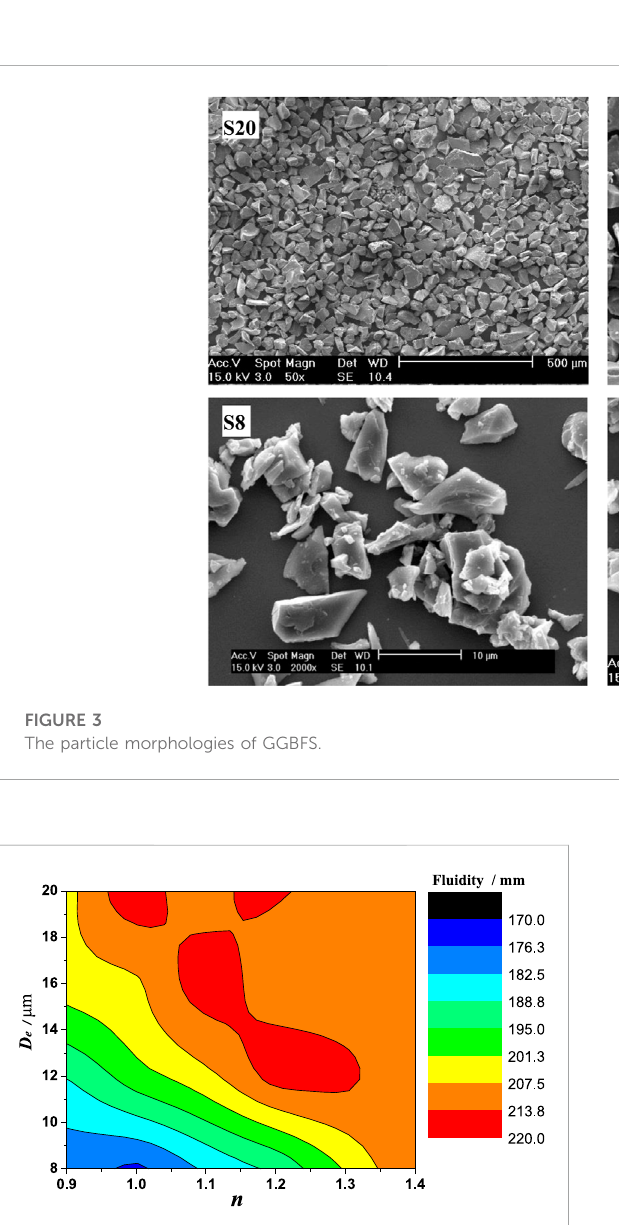
FIGURE 4 The in fl uence of the PSD characteristics on mortar fl uidity without PCE.